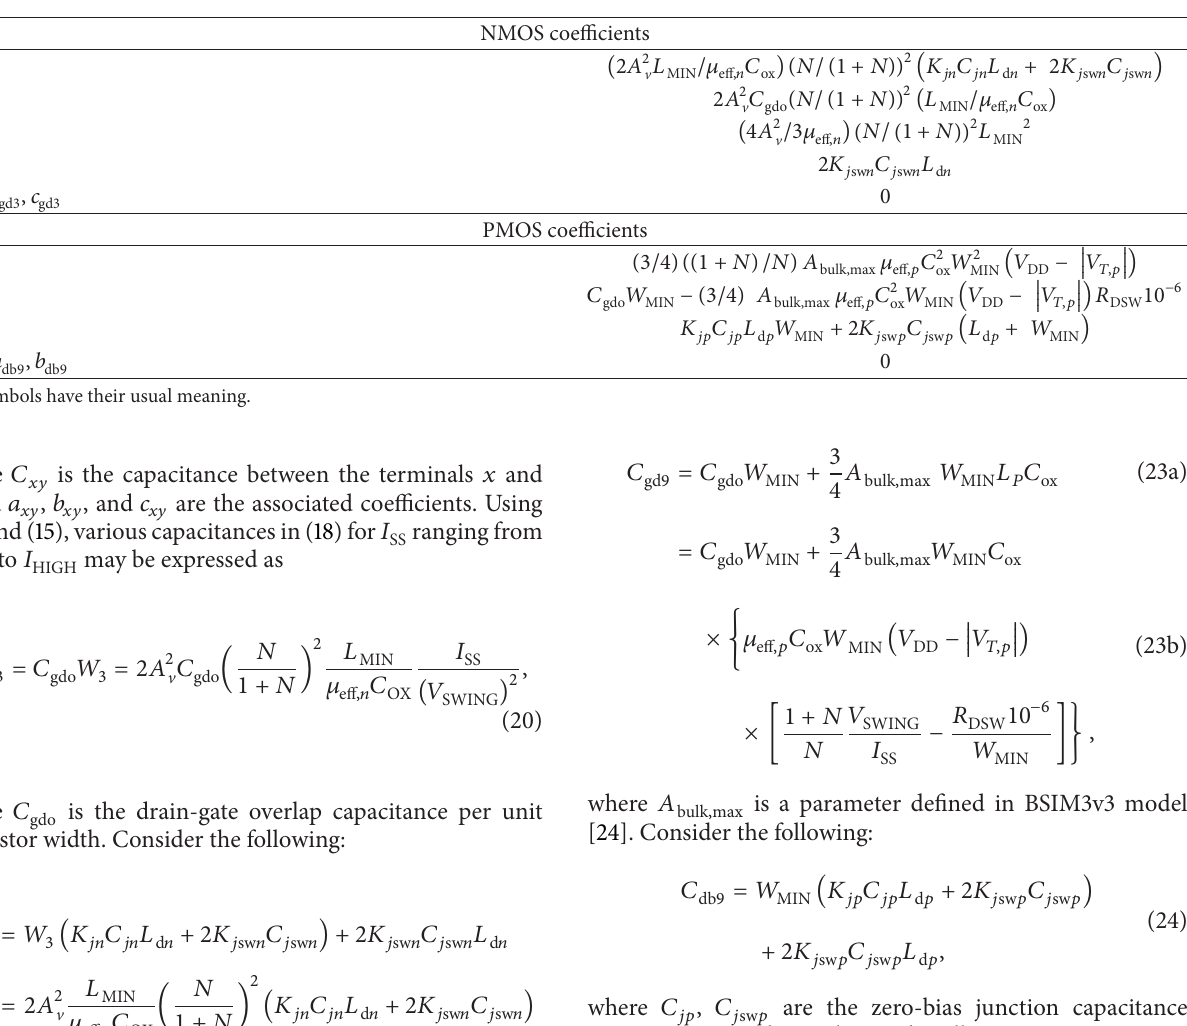
Table 3: Coefficients of the capacitances for the proposed